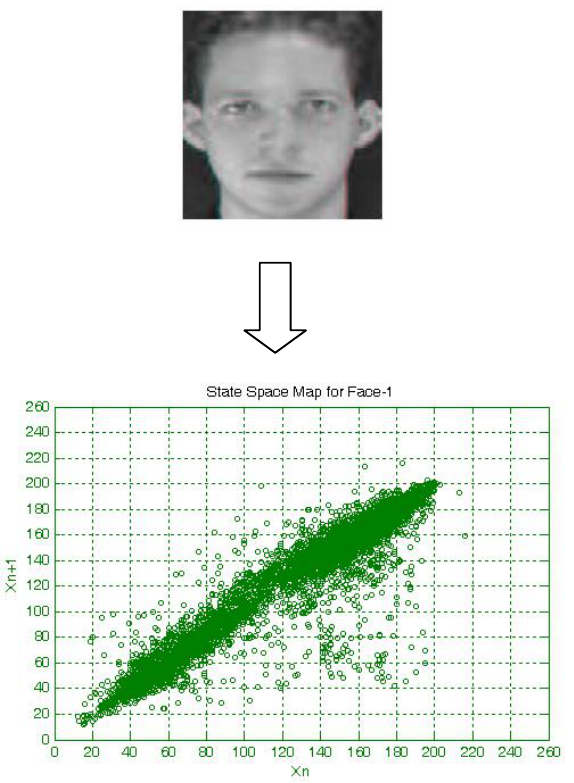
Fig. 1. State space map for face image of a person in AT & T face database.